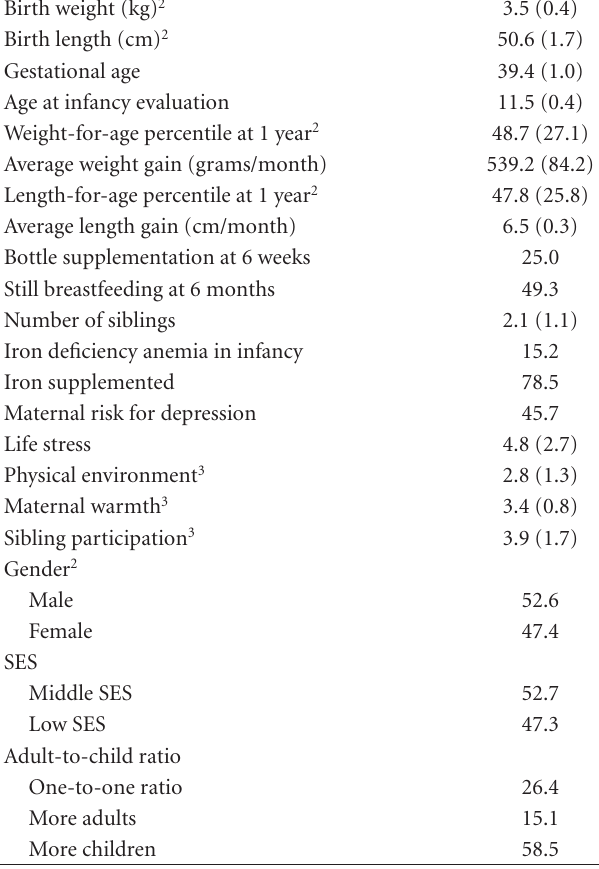
Table 2: Descriptive statistics of Chilean infants ( n = 999) 1 .